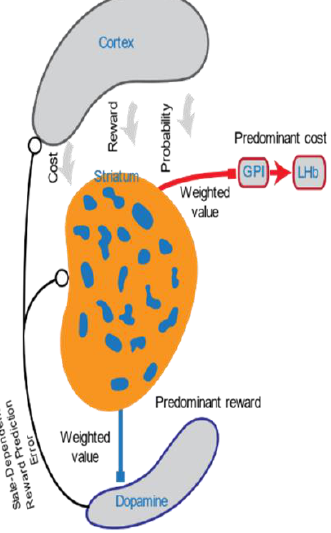
Figure 1. Dorsomedial striatum (DMS) striosomes lie at the center of the Cortico-Striosomal, Lateral Habenula, Dopaminergic Evaluation Circuit. Striosomes encode the subjective value of reward, cost, and uncertainty, and integrate these signals. DMS striosomes selectively project to the SNC (predominant source of reward) and Lateral Habenula.